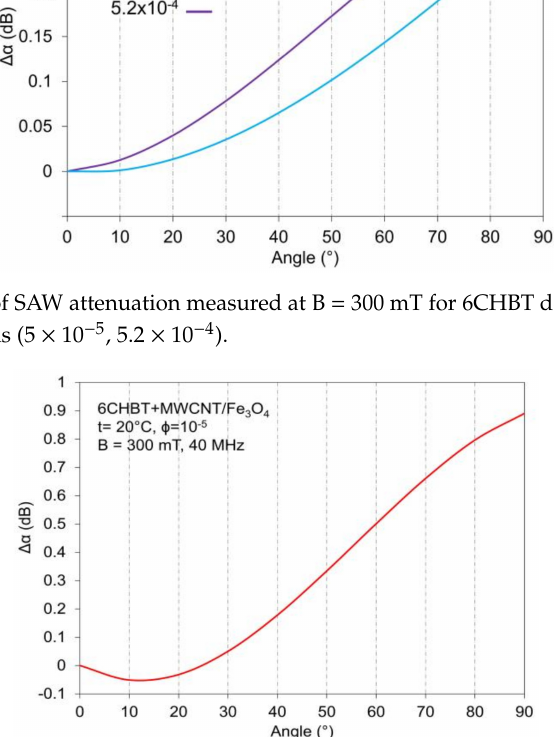
Figure 9. Anisotropy of the acoustic attenuation measured at B = 300 mT and at frequency 40 MHz for 6CHBT doped with MWCNT / Fe 3 O 4